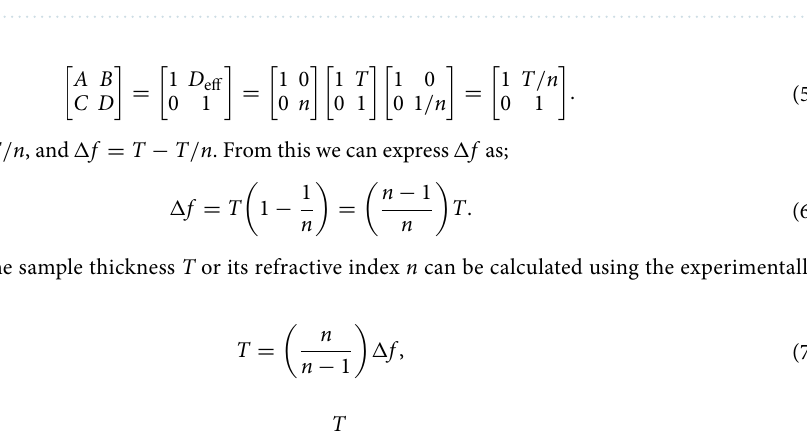
Figure 3. Change in the effective air-equivalent propagation distance D eff before and after sample insertion and the required focal length retuning to regain interferometric balance after sample